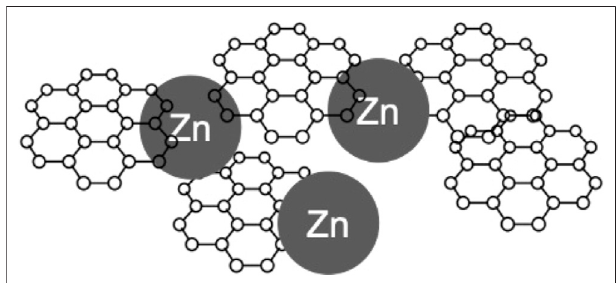
FIGURE 9 | Schematic representation of Zn nanoparticles (100 nm) bridging graphene fl akes, enabling a conductive